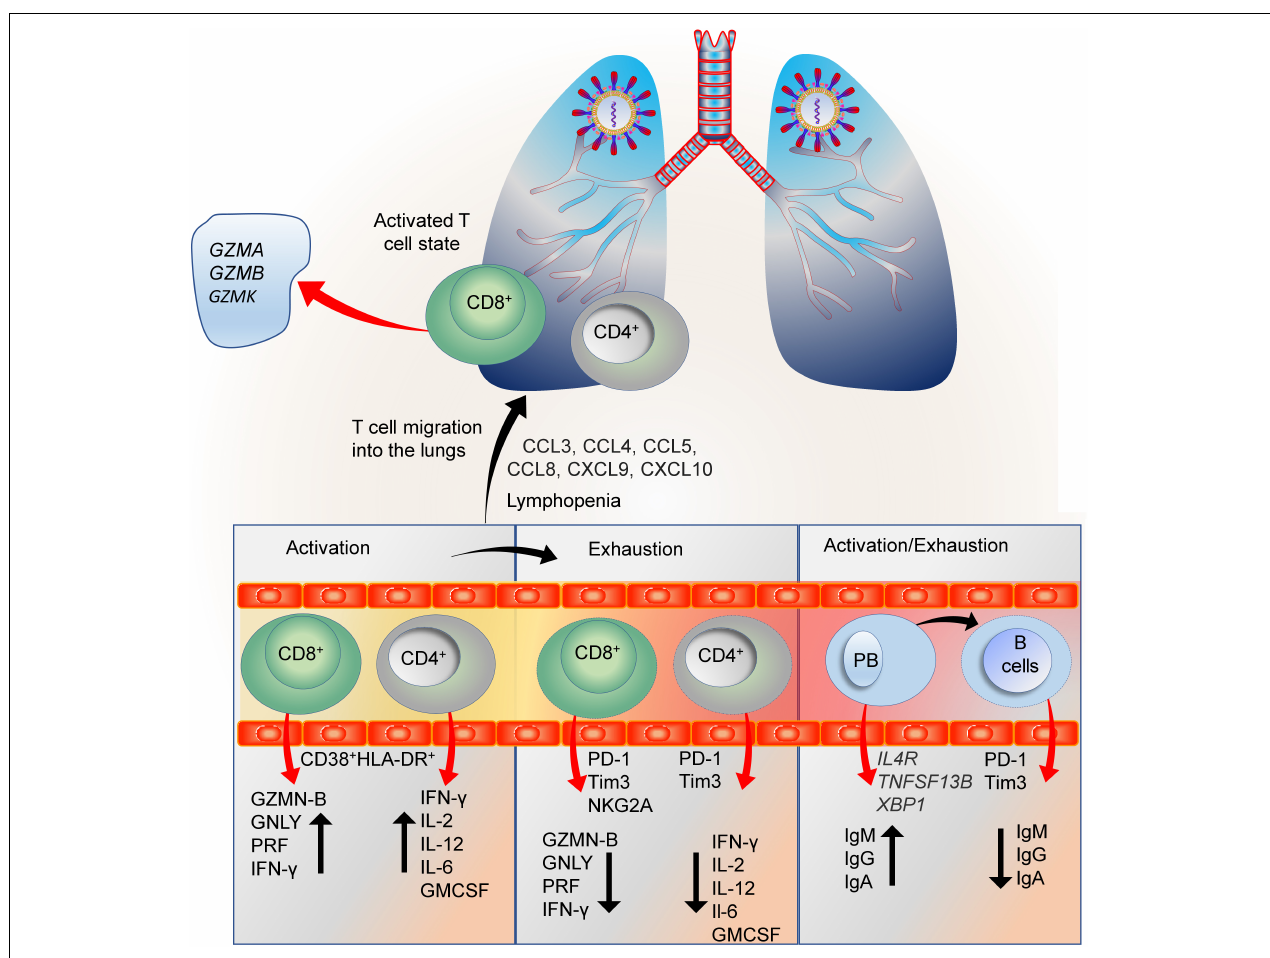
FIGURE 4 | T and B cell immune response during SARS-CoV-2 infection. (A) The activation status of CD4 + and CD8 + T in the circulation is indicated by CD38 + HLA-DR + . These activated T cells are further recruited at the sites of infection (initially lungs) in the presence of their respective chemokines. The activated CD4 + T cells are marked by the presence of cytokines like IFN- γ , IL-2, IL-12, IL-6, and GM-CSF, whereas activated CD8 + T (cytotoxic T cells) are marked by the secretion of granzymes, perforins, and IFN- γ . During SARS-CoV-2 infection, activated CD8 + T cells exhibiting increased expression of granzyme A, B, and K (GZM-B, GZM-A, and GZM-K) were found in the lungs (Liao et al., 2020; Song et al., 2020; Zheng M. et al., 2020). (B) T cells were also found to exhibit exhausted state as marked by the expression of PD-1, Tim3, and NKG2A. However, most studies showing exhausted T cells were confined to the peripheral blood, while lungs were mostly shown to have activated T cells but with concomitant expression of some exhaustive markers, suggesting that the activation state is followed by exhaustion. The exhaustive T cells are marked by the reduced expression of respective chemokines and cytolytic granules. (C) Similarly, antibody-producing B cells (plasmablasts; PB) were shown to exhibit activation status as reflected by the expression of IL4R, TNFSF13B, and XBP1, while at the same time, the exhausted status of these cells was also reported in the peripheral blood. Exhaustive state of B cells is reflected by a decrease in antibody